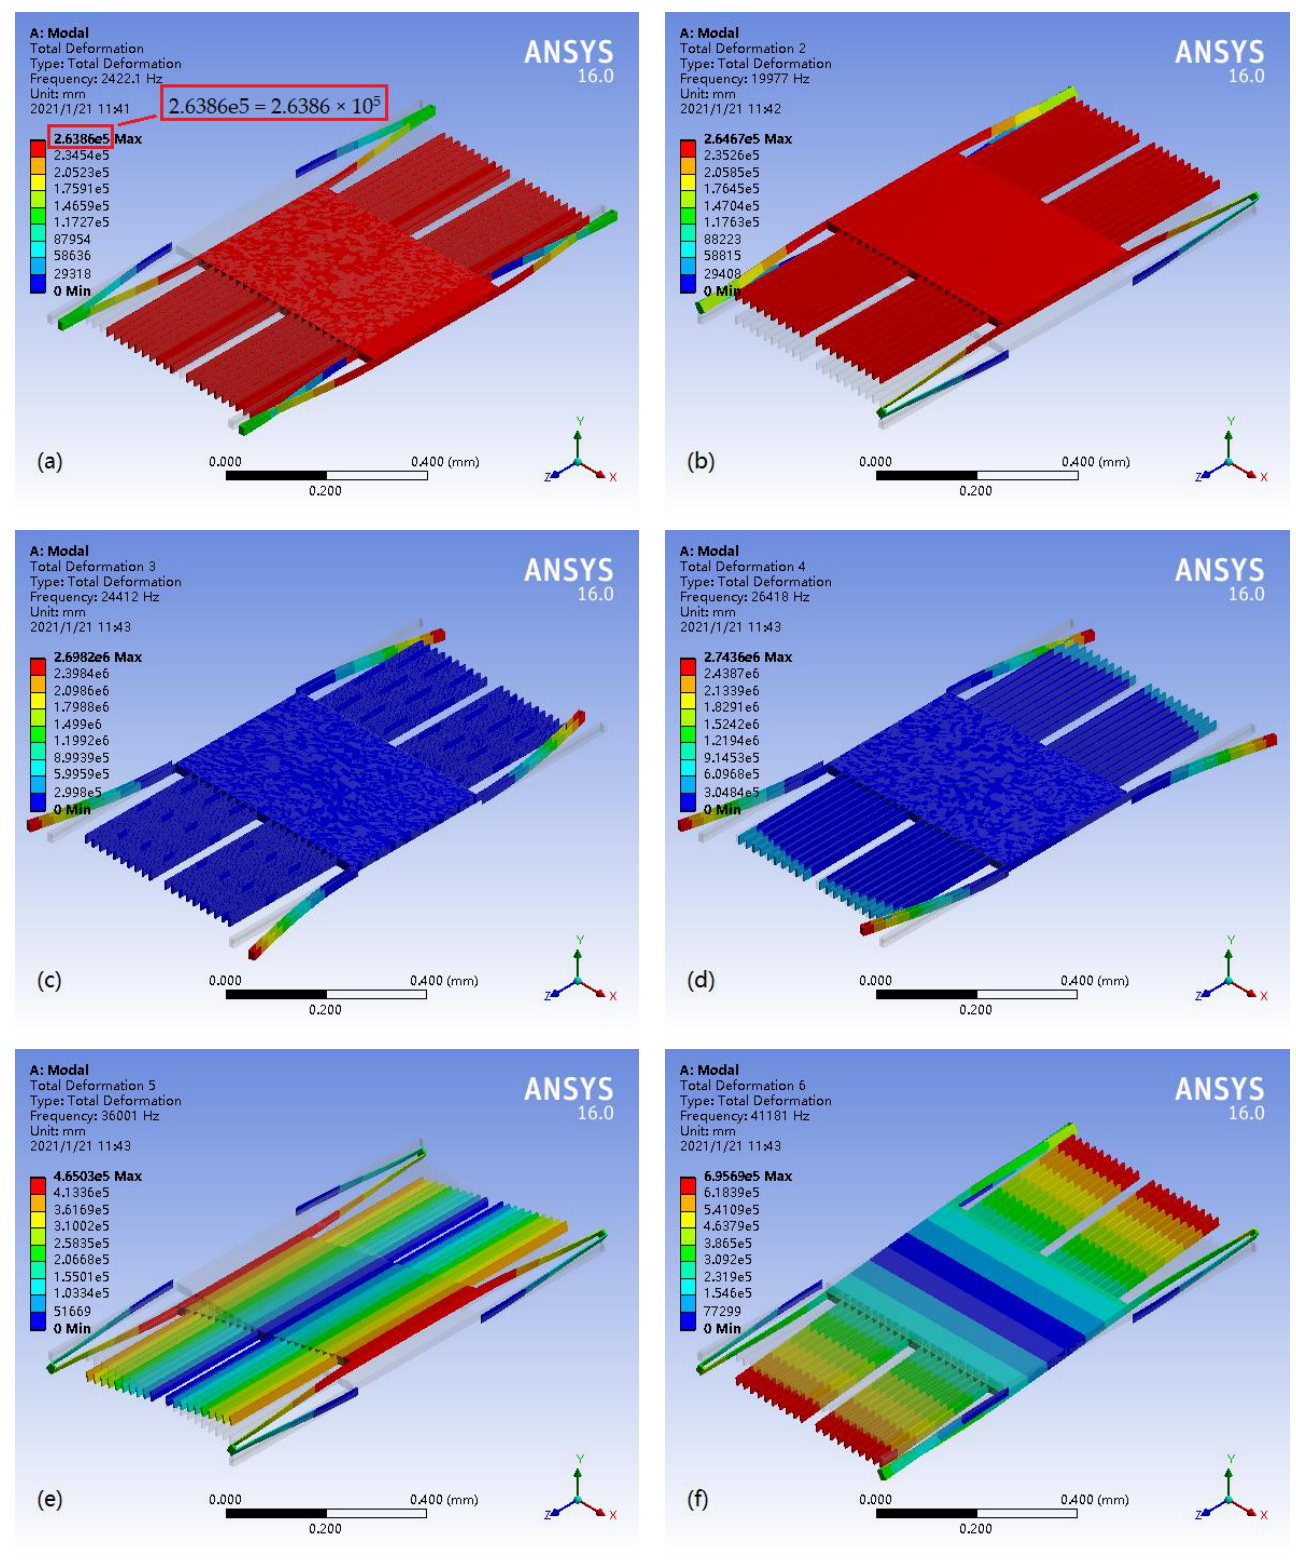
Figure 4. Modal analysis of the capacitive accelerometer based on the SiC microstructure. ( a ) The first mode is the translational motion along the x -axis; ( b ) the second mode is the translational motion along the y -axis; ( c ) the third mode is the translational motion along the z -axis; ( d ) the fourth mode is the rotational motion around the y -axis; ( e ) the fifth mode is the rotational motion around the z -axis; ( f ) the sixth mode is the rotational motion around the x -axis.